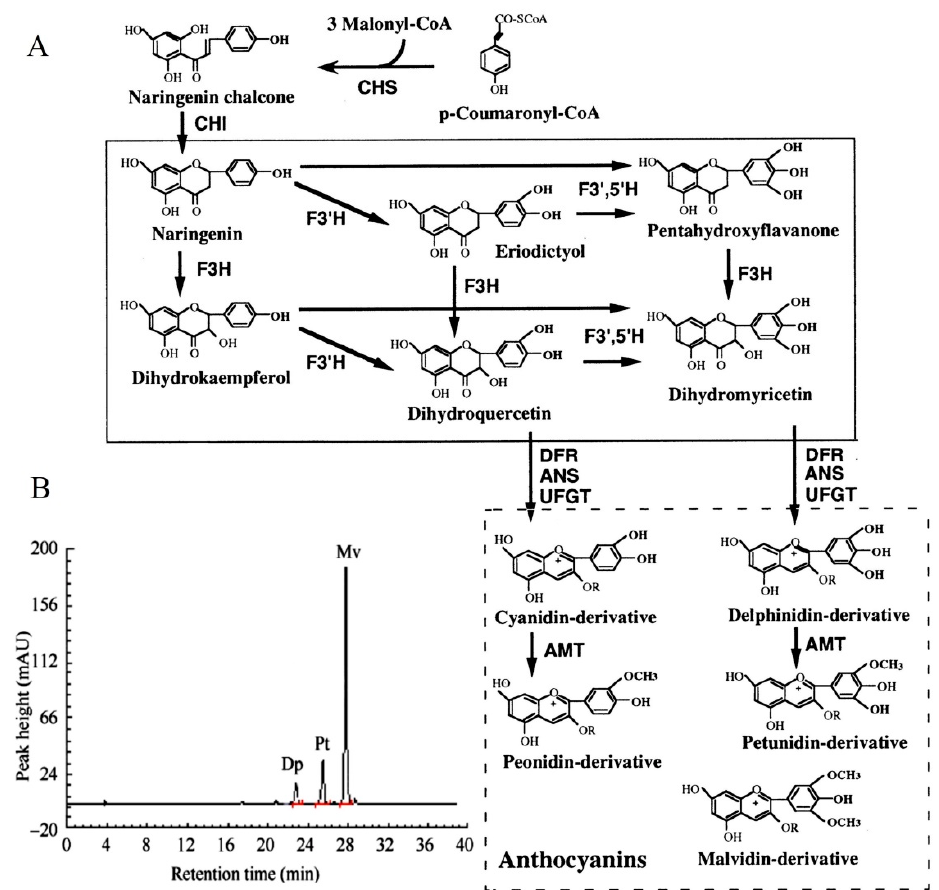
Figure 1. The color change of petals during flower opening and simplified representation of the anthocyaninsbiosynthetic pathway. ( A ) The anthocyanin composition of bud petals (0 d) in B. acuminata by HPLC [2]. Dp, delphinidin-3-glucoside; Pt, petunidin-3-glucoside; Mv, malvidin-3- O -glucoside. ( B ) The simplified representation of anthocyanins biosynthetic pathway. CHS, chalcone synthase; CHI, chalcone isomerase; F3H, flavanone-3-hydroxylase; F3 ′ H,Flavonoid-3 ′ -hydroxylase; F3 ′ 5 ′ H, Flavonoid-3 ′ ,5 ′ -hydroxylase; ANS, anthocyanin synthase; UFGT, UDP-glucose:3-O-flavonoid glucosyl transferase; DFR, dihydroflavonol-4-reductase; AMT, anthocyanin methyltransferase [3].